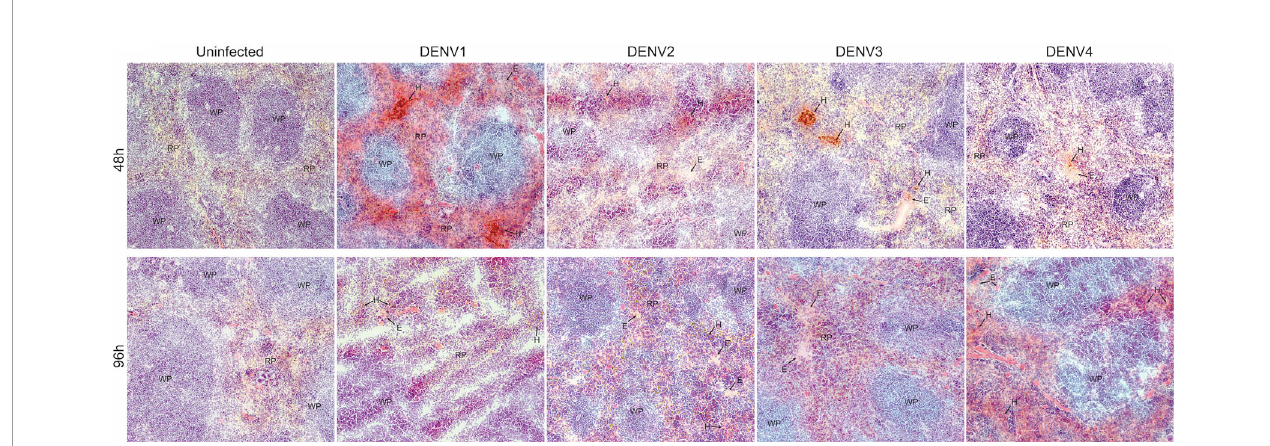
FIGURE 6 | Hemorrhaging and edema in the spleen of mice infected with DENV1-4. Histological evidence of hemorrhaging (H) and edema (E) in the red pulp of the spleen of mice infected with DENV1-4 at 48h and 96h post-infection. Red pulp (RP) and white pulp (WP) are also labeled. Images were taken at 10x magni fi cation and representative images from 3 animals are